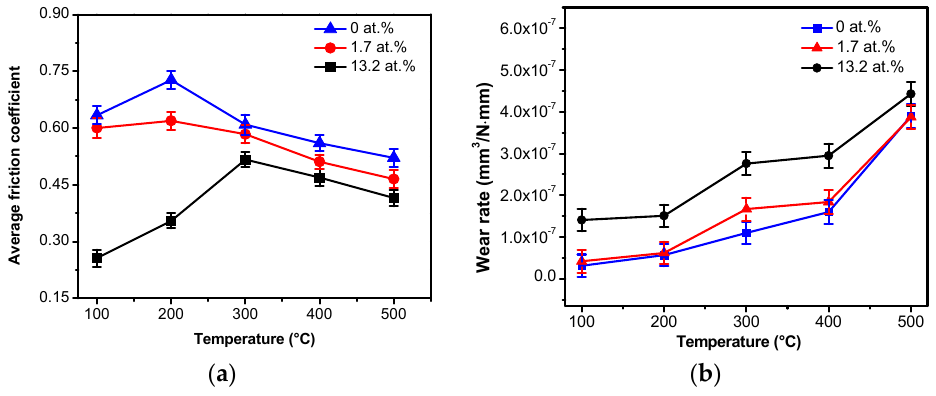
Figure 8. ( a ) Friction coefficient and ( b ) wear rate of VCN–Cu films at different temperatures.